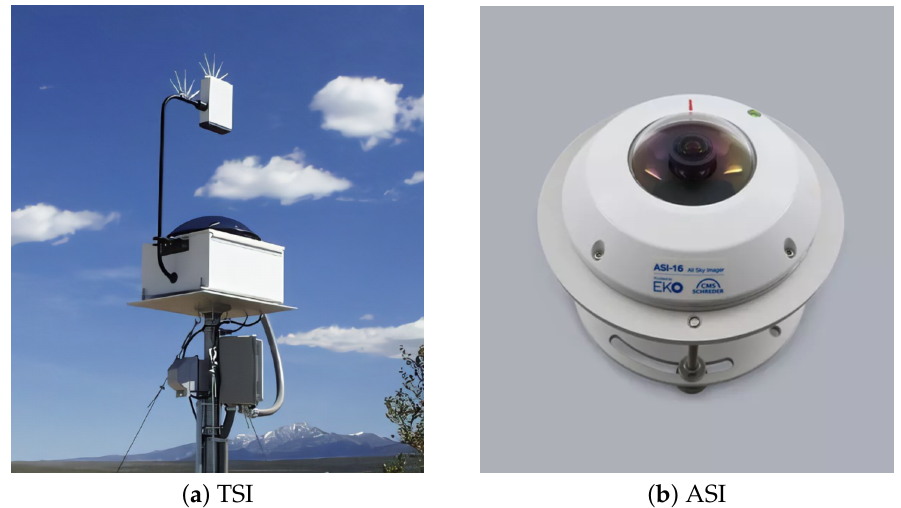
Figure 1. Examples of Total Sky Imager (TSI) (source of picture: https://gml.noaa.gov/grad/ surfrad/tsipics.html, accessed on 30 October 2022) and All Sky Imager (ASI) (source of picture: https://www.eko-instruments.com, accessed on 30 October 2022). ( a ) The TSI is composed of a web camera suspended over a convex mirror. ( b ) The ASI-16 All Sky Imager utilizes a 5MP camera and fish-eye lens with an anti-reflective coated quartz